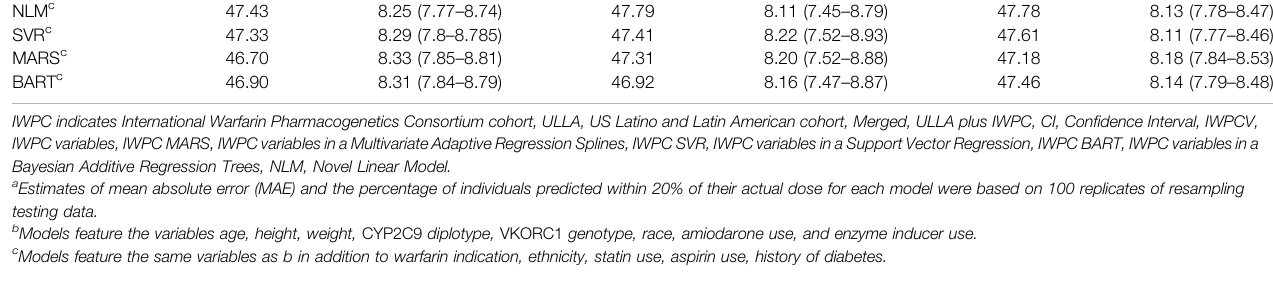
TABLE 2 | Comparison of Warfarin Dose Prediction Algorithms by Median Percentage Predicted within 20% of Actual and Mean Absolute Error (MAE) in the IWPC, ULLA, and Merged cohorts. IWPC ( n = 5,049) ULLA ( n = 1,734) Merged ( n = 7,030) Within 20% a MAE Within 20% a Model Within 20% a MAE (95%CI) a (95%CI) a IWPC b